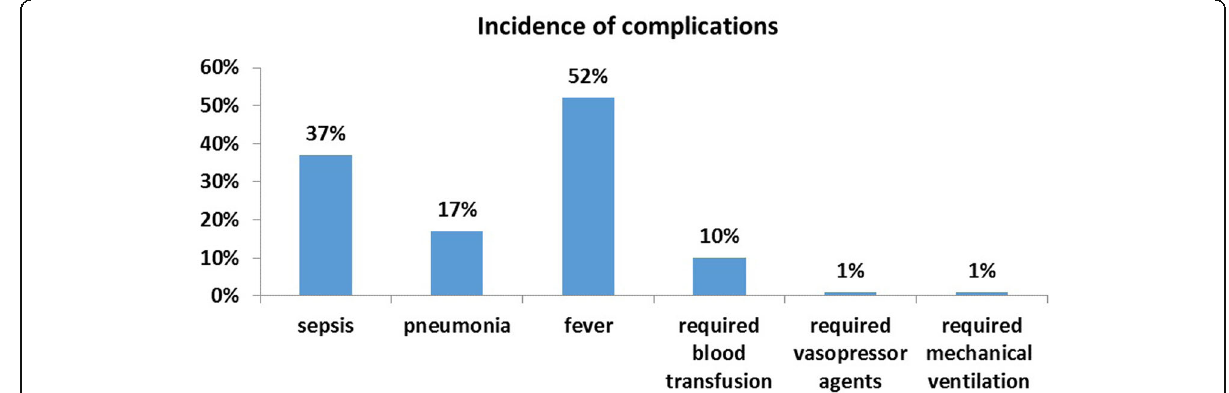
Fig. 4 Incidence and type of ICU complications. Data presented as